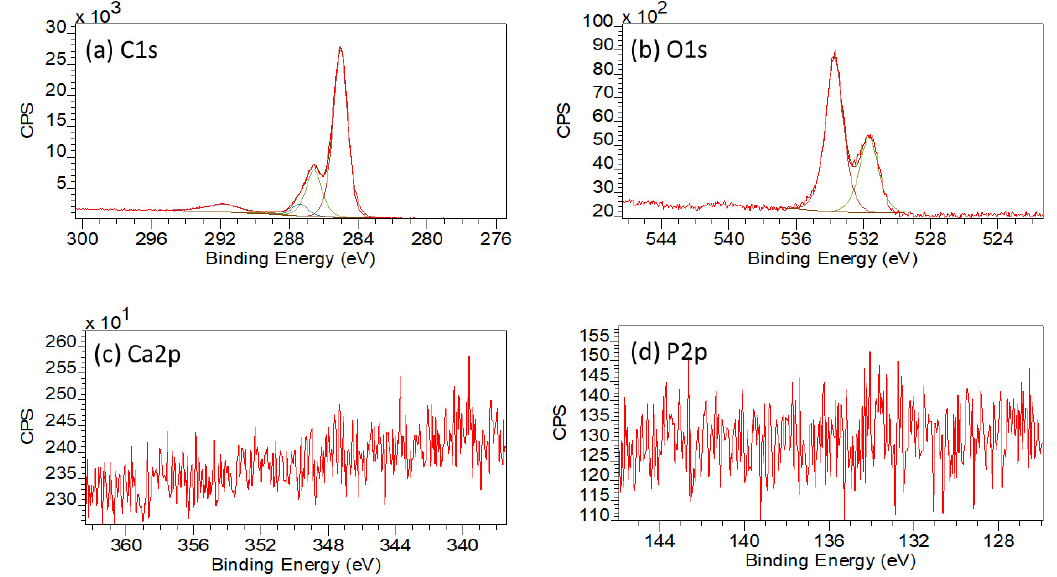
Figure 6. XPS high resolution scans for 0HA where ( a ) C1s, ( b ) O1s, ( c ) Ca2p, and ( d ) P2p.